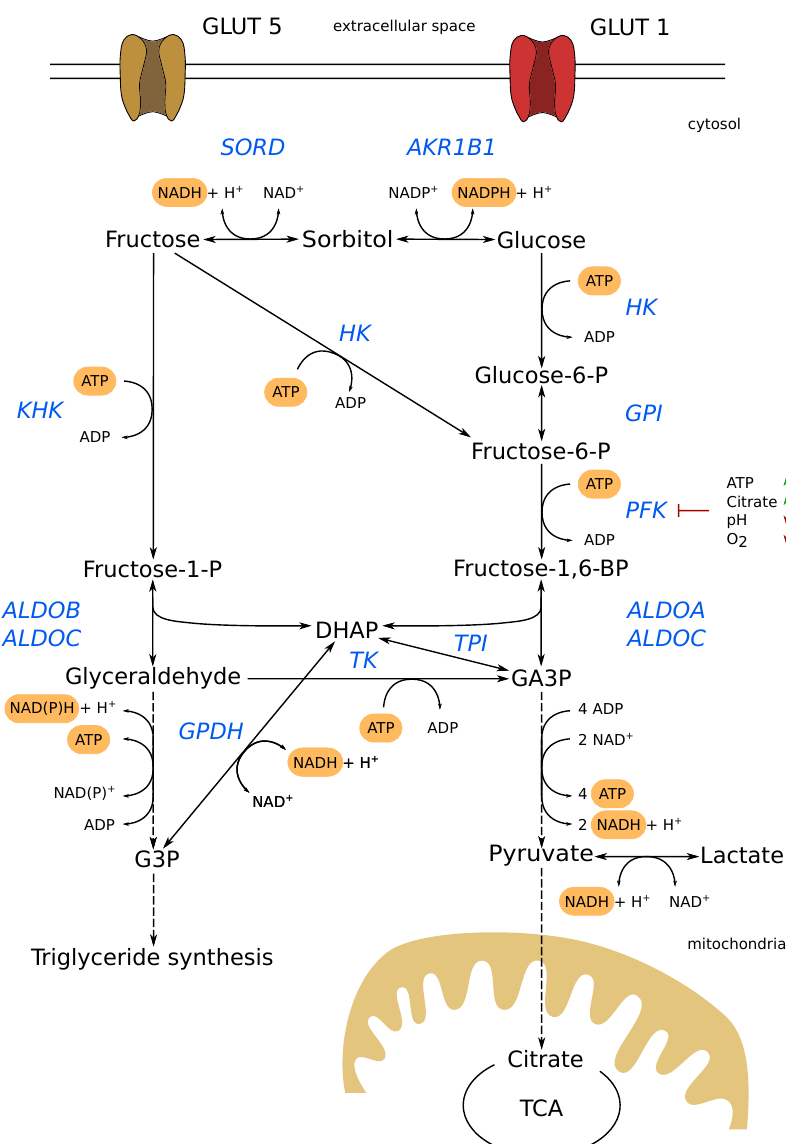
Figure 1. Overview of fructose and glucose degradation pathways. Fructose uptake is mediated by GLUT5 and can be metabolized via different pathways: (1) phosphorylation via KHK to F1P, which is then hydrolyzed by aldolase B to DHAP and GA. Subsequently, fructose carbons can therefore enter glycolysis and the pentose phosphate pathway. (2) Phosphorylation via HK, entering glycolysis in the form of F6P, and (3) via the polyol pathway producing glucose which in turn can enter gylcolysis. Glucose can be taken up by several glucose transporters (here GLUT1) and is metabolized via glycolysis. Glucose can also be used for endogenous fructose production providing the possibility to bypass PFK. PFK is the rate-limiting enzyme of glycolysis and is inhibited by high levels of ATP and citrate as well as low pH and low oxygen levels. From an energetic point of view, the degradation pathways from fructose and glucose to pyruvate do not differ. Fructose degradation via KHK to GA3P consumes two ATP just as glucose in glycolysis. In the pay off phase, both pathways generate four ATP and two NADH+H + . Bypassing PFK inhibition by endogenous fructose production, however, consumes one additional NADPH+H + and produces one NADH+H +